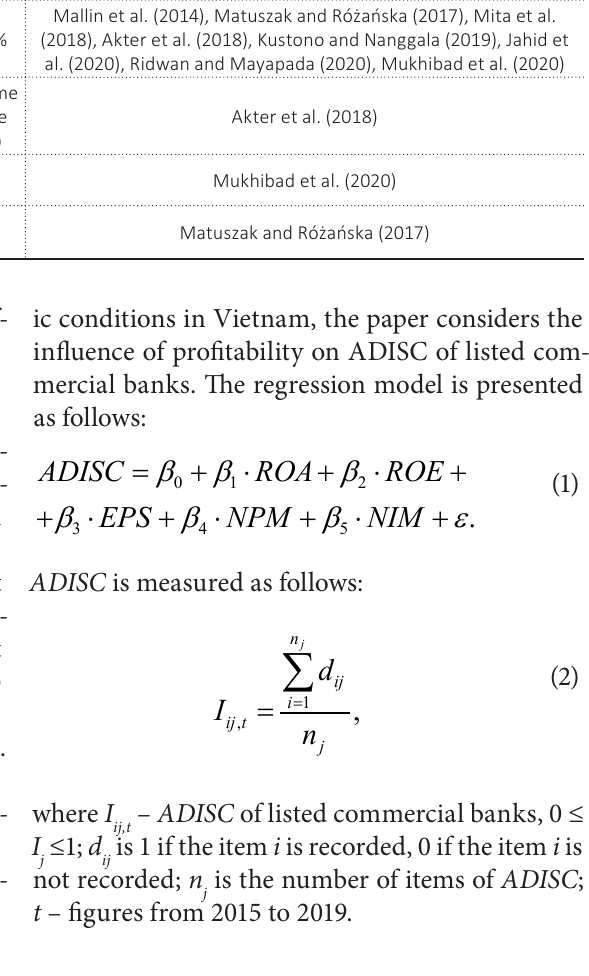
Table 1. Defining and measuring independence variables